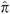
Four diagnostic plots to describe discrimination in a model fit with an area under operating characteristics curve of 0.85.In survivors, the predicted probability of death (π^) gathered below 0.2, indicating a good negative predictive power of the model. However, π^ scattered more evenly in non-survivors, indicating a limited power of positive predictive value.